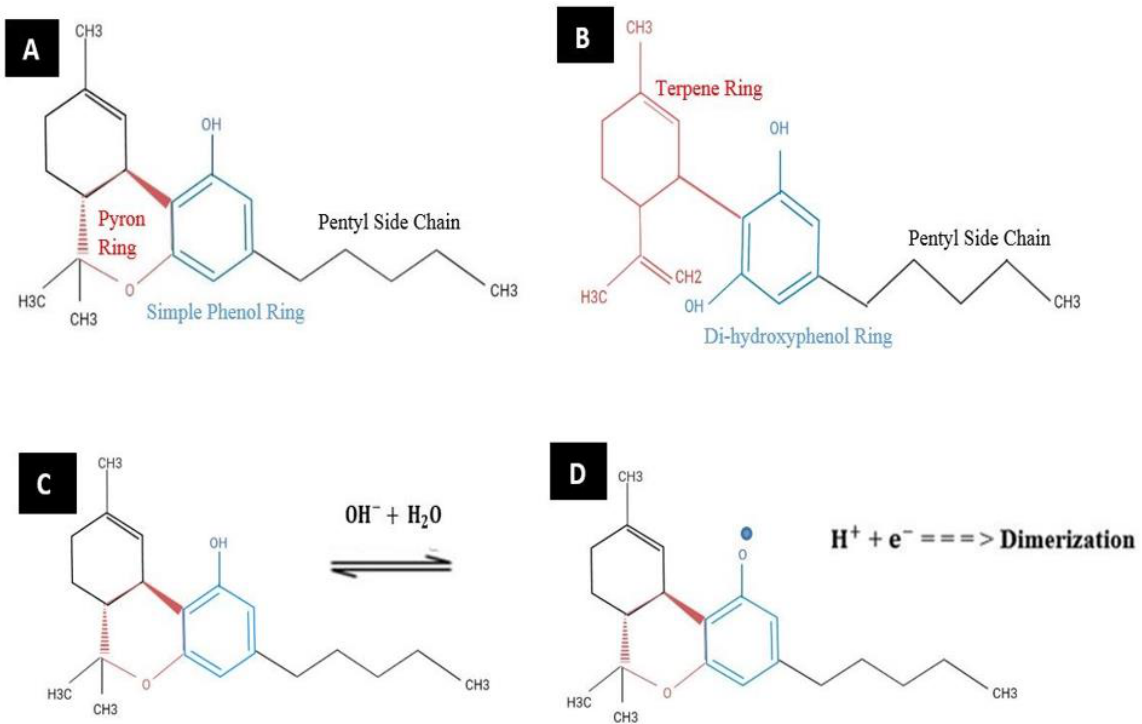
Figure 1 . Chemical structures of ( A ) Δ 9 -tetrahydrocannabinol (Δ 9 -THC) and ( B ) cannabidiol (CBD). Figure 1. Chemical structures of ( A ) ∆ 9 -tetrahydrocannabinol ( ∆ 9 -THC) and ( B ) cannabidiol (CBD). Irreversible oxidation of Δ 9 -THC: ( C ) before and ( D ) after deprotonation. Reprinted and adapted Irreversible oxidation of ∆ 9 -THC: ( C ) before and ( D ) after deprotonation. Reprinted and adapted with permission from ref. [5]. Copyright 2020 American Chemical Society. with permission from ref. [5]. Copyright 2020 American Chemical Society.